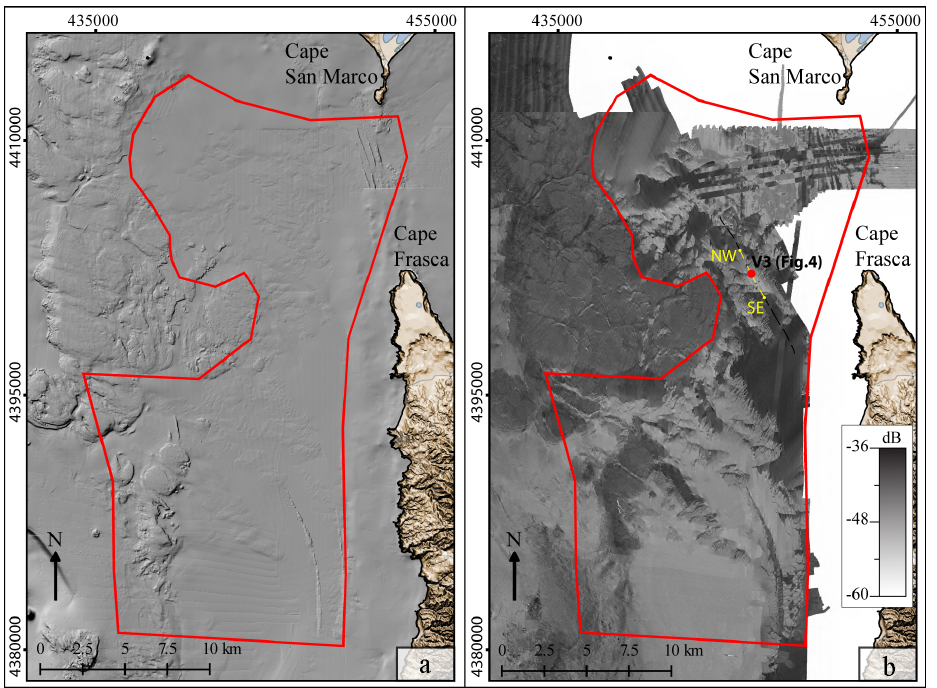
Figure 3. (a) Shaded relief map of a digital terrain model of the study sector; (b) distribution of relative backscatter intensity values of the same sector.